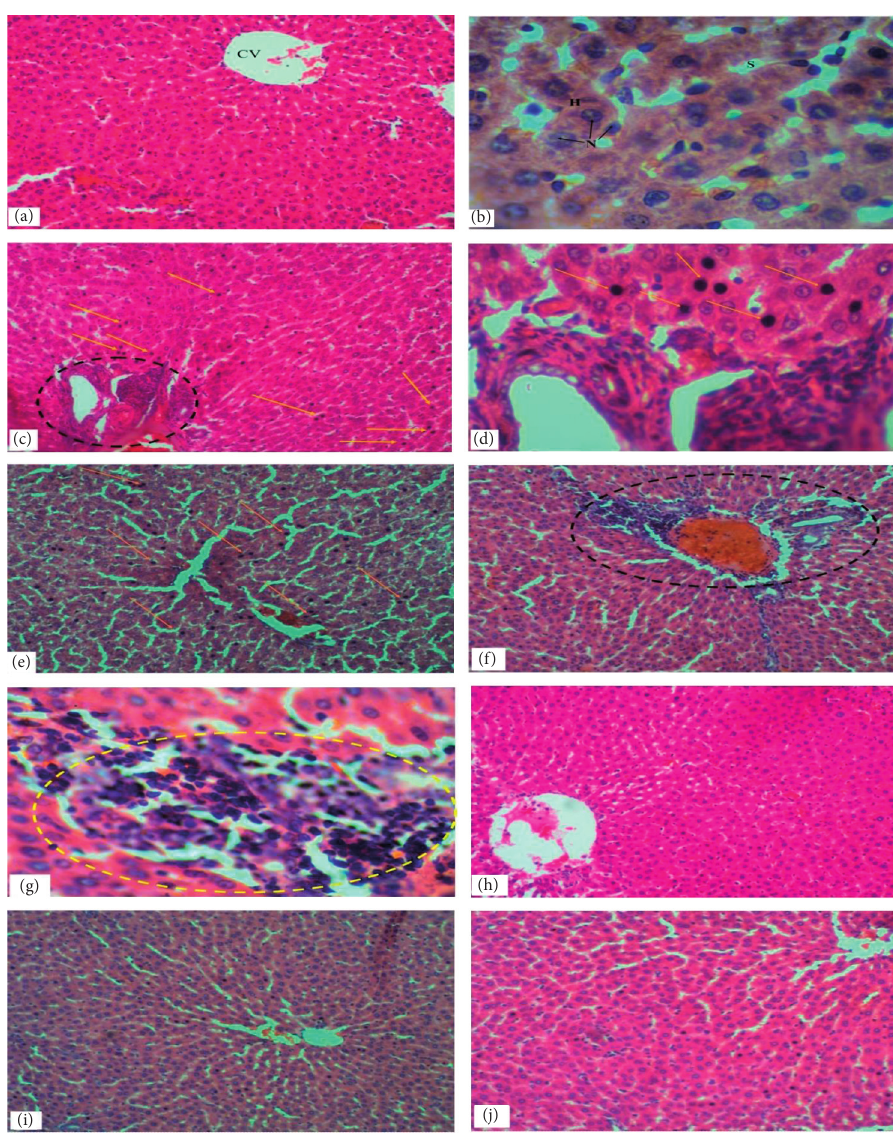
Figure 1: Cross sections of the liver stained with H&E. (a, b) Hepatic tissue of the control group demonstrating normal parenchymal structure, intact lamellar pattern of the hepatocytes (H) and Kupffer cells, and normal sinusoidal architecture (S), and no significant lesions were observed. (c, d) Hepatic tissue of Pb only treated rat showing evidence of focal necrotic areas accompanied with inflammatory cell infiltrations (black dotted circle) and high distributed necrosis (yellow arrows) in the liver. (e) Hepatic tissue of Cu only treated rat showing evidence of high distributed necrosis in the liver (yellow arrows). (f, g) Hepatic tissue of both Cu and Pb recovery group rats, respectively, showing evidence of focal necrotic areas accompanied with inflammatory cell infiltrations (black and yellow dotted circles) and mild disseminated necrosis in the liver. (h–j) Hepatic tissue of rat treated with heavy metals+100 mg, 200mg, and 300mg of EEVA, respectively, showing improvement in parenchymal structure and normal hepatic histoarchitecture (mic. mag. (a, c, e, f, h, i) × 100; (b, d, g) ×